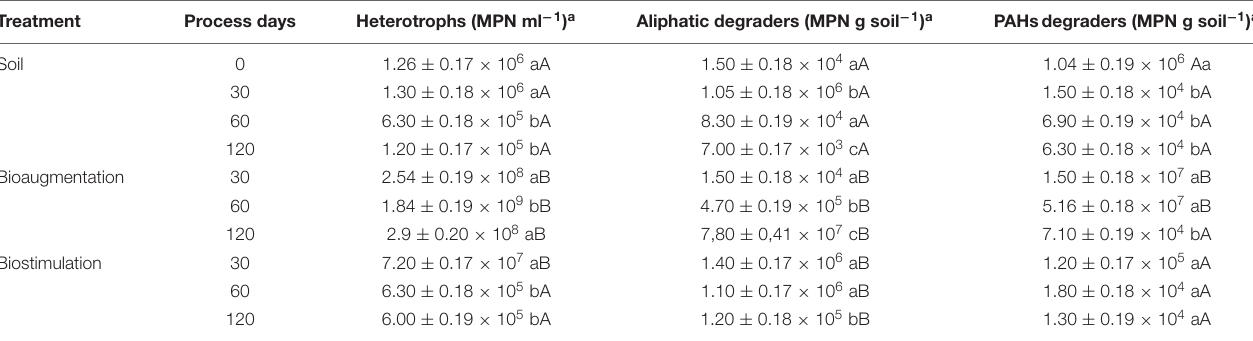
TABLE 3 | Time-course evolution of the most probable number (MPN) of specific microbial populations during microcosm incubations.